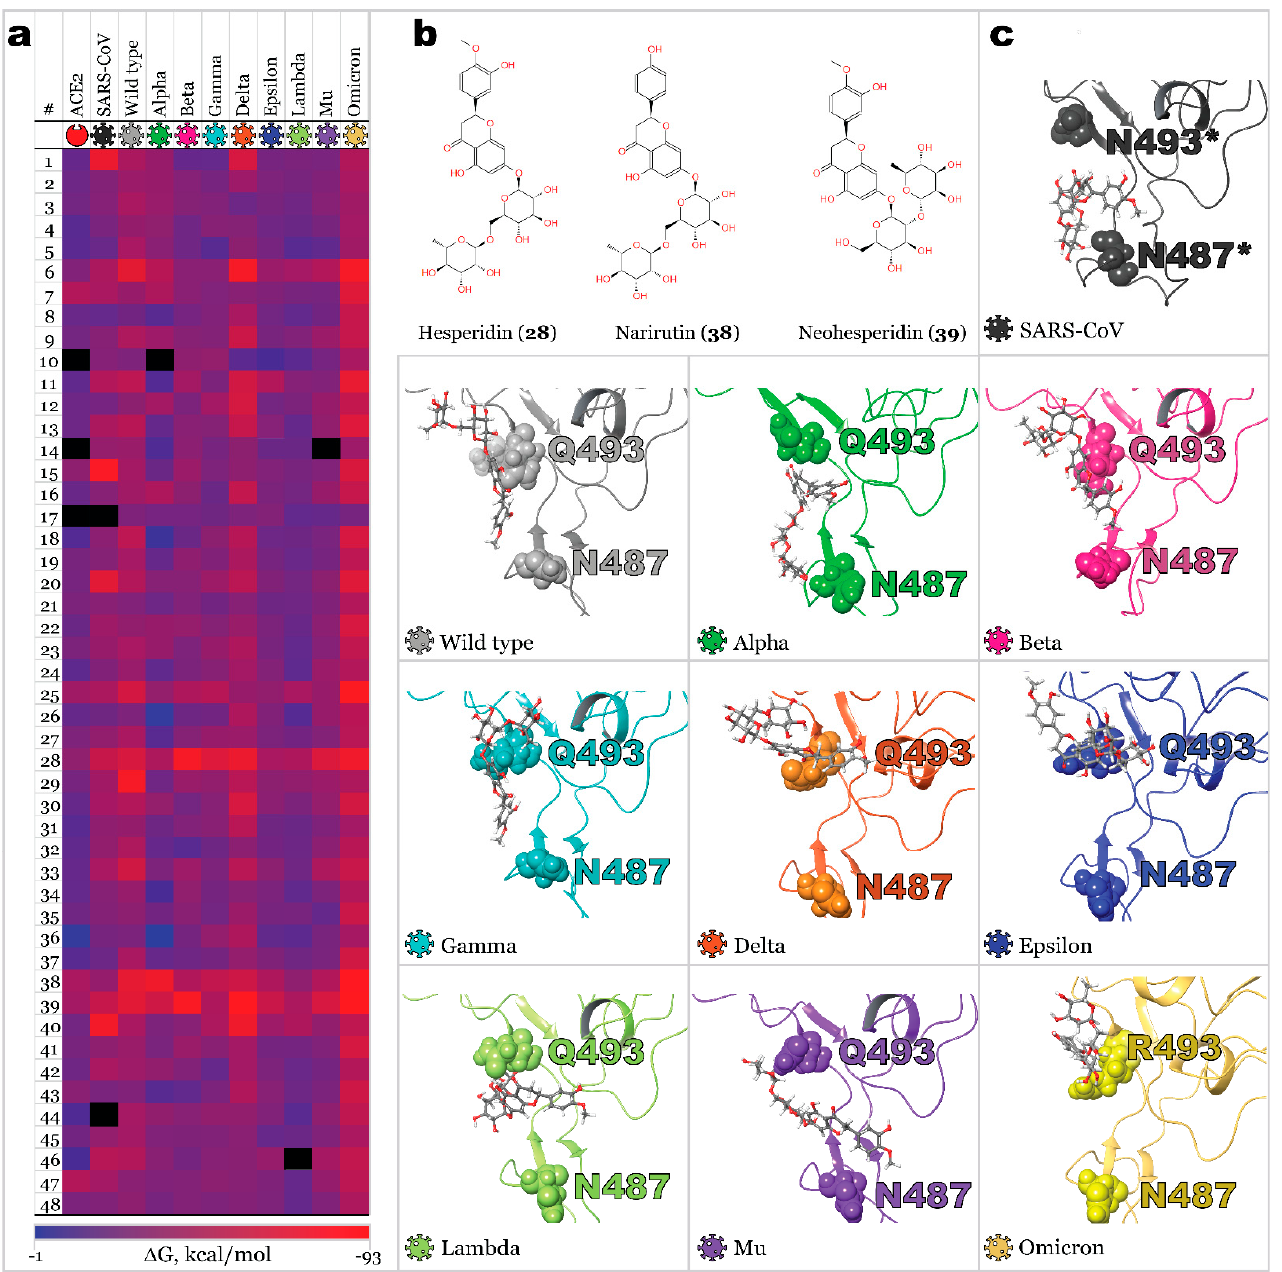
Figure 6. Results of MM-GBSA calculation: ( a )—Free binding energies of ligand-protein complexes presented as heat maps; ( b )—Active compounds with the highest averaged affinity towards most SARS-CoV-2 RBD variants; ( c )—3D structures of RBDs complexed with compound 28 (residues of interest are illustrated with CPK representation). * original sequence numeration for SARS-CoV was changed in this figure according to the alignment of residues for easier